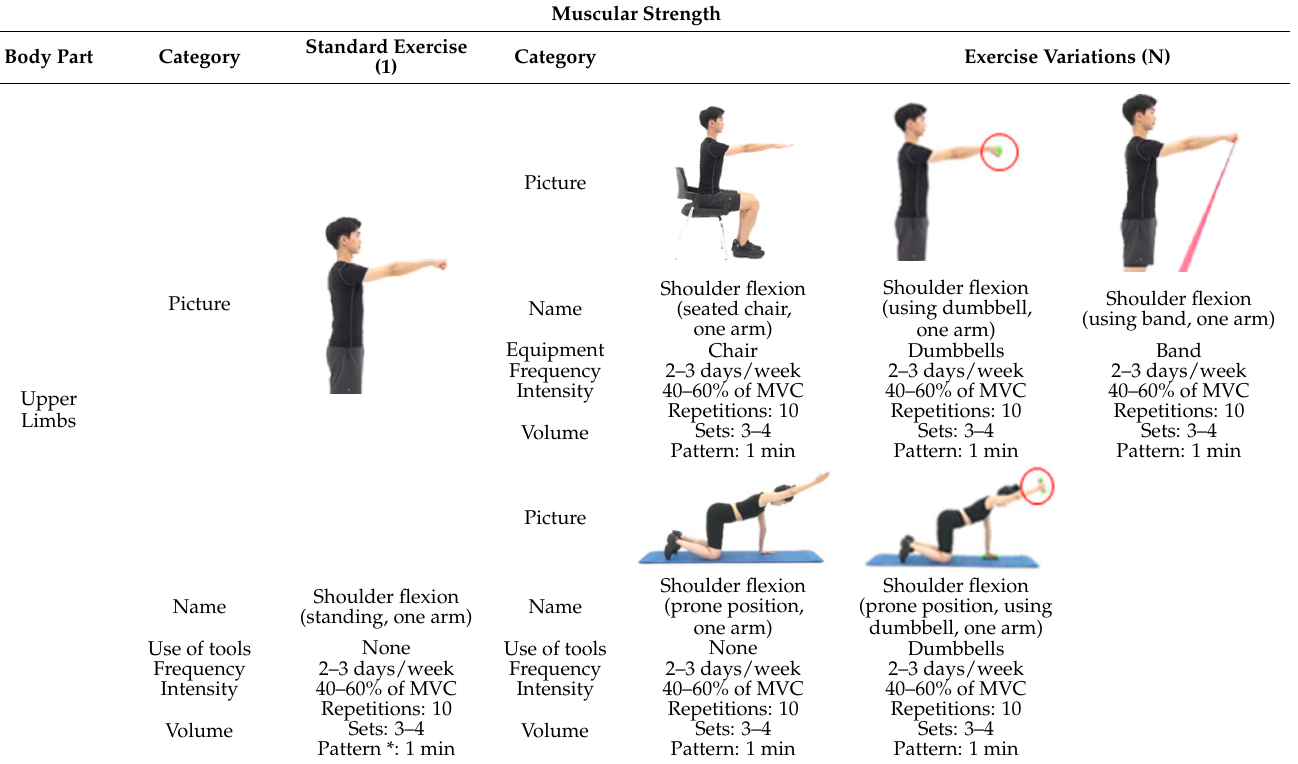
Table 4. Examples of 1: N movement classification.